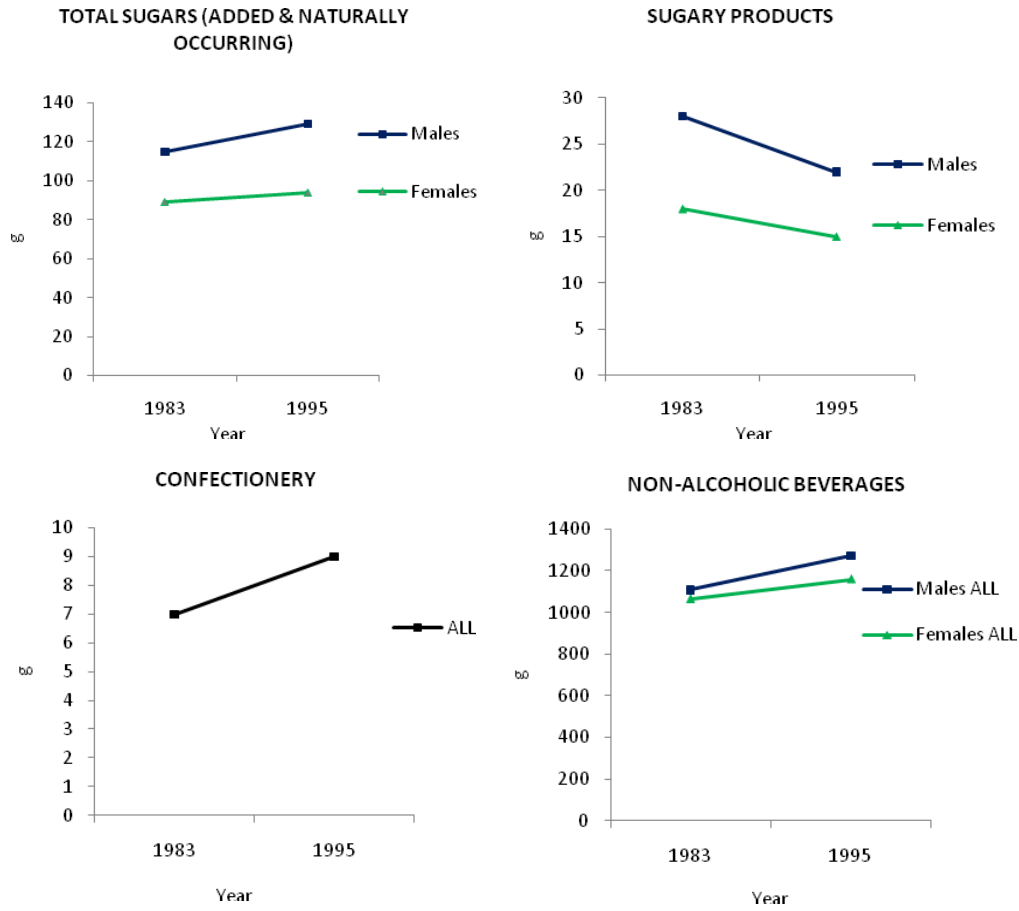
Figure 3. 24 h mean intake (g) of total sugars, sugary products, confectionery and non-alcoholic beverages * by Australian adults (25–64 years) in 1983 and 1995